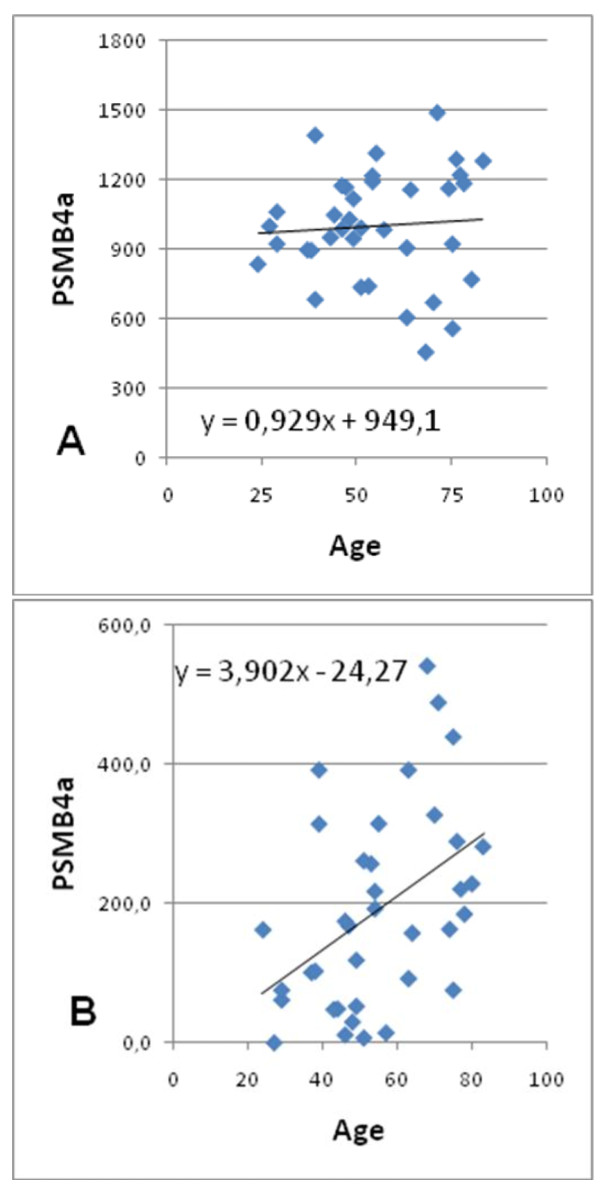
Illustration of procedure used to evaluate the contribution of a probe to an effect of age on deviation index. Figure 2A shows the transcript abundance of probe PSMB4a in database BB of males in M libraries To generate the residual errors in Figure 2B, all data points were reduced with 1000 and resulting negative residual errors were converted to positive values. In this case of PSMB4a the regression with age is positive and significant (P = 0,005).